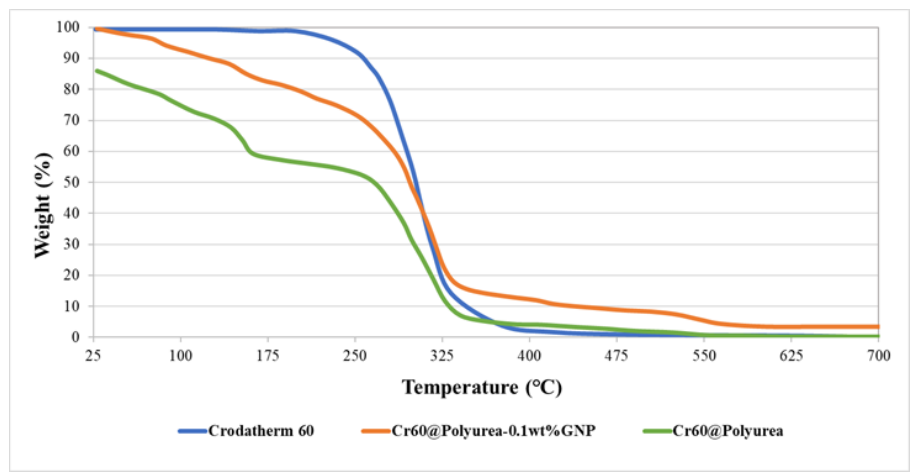
Figure 6. TGA graphs of Cr60, Cr60@polyurea, and Cr60@polyurea-0.1%GNP.